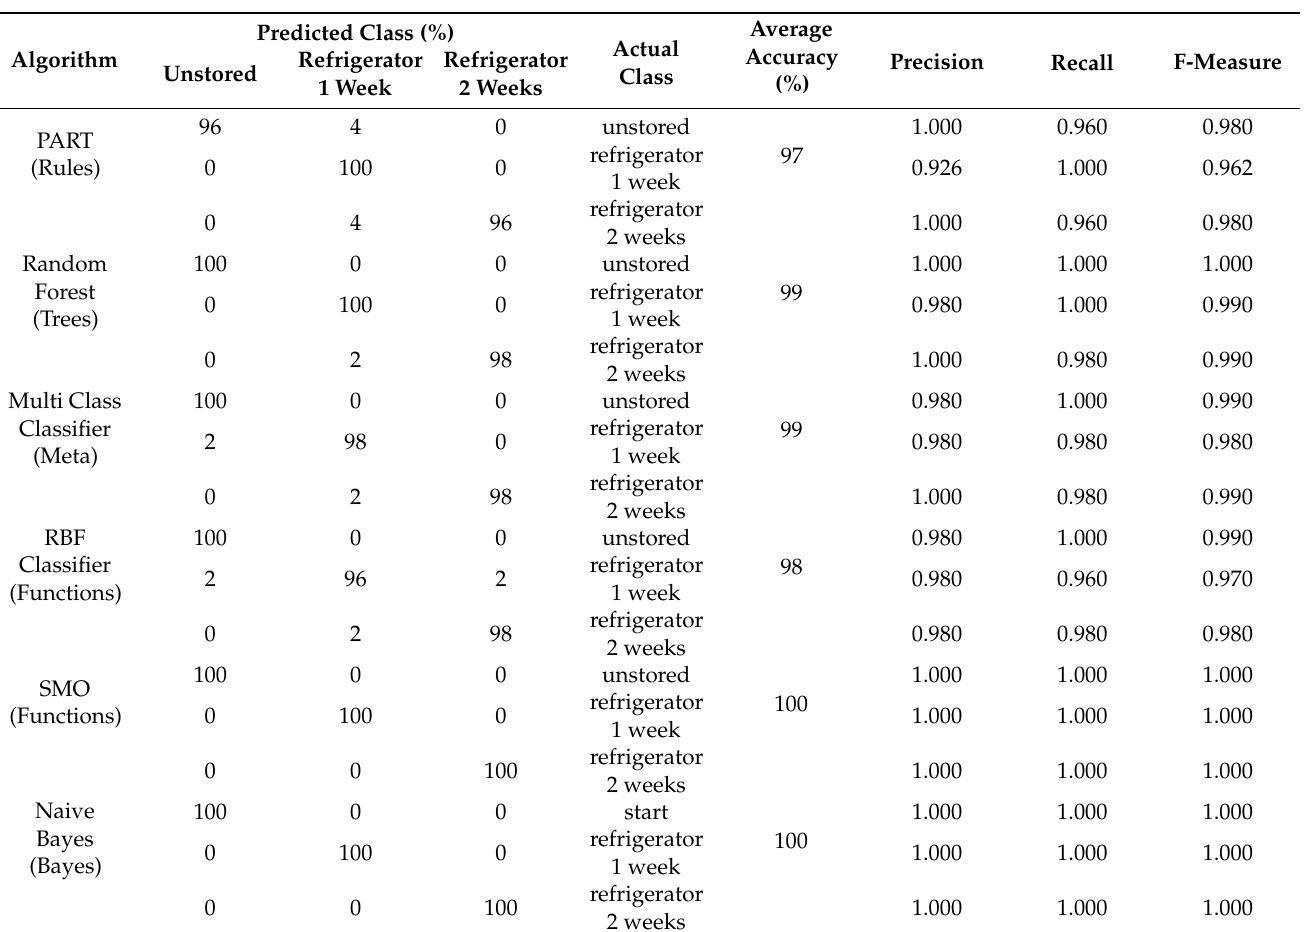
Table 2. The performance metrics of the classification of unstored red currants, and samples stored in the refrigerator for one week, and stored in the refrigerator for two weeks using models built using various machine learning algorithms based on combined selected textures from color channels R , G , B , L , a , b , X , Y , and Z